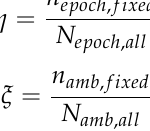
Figure 9. Distribution of European reference stations.